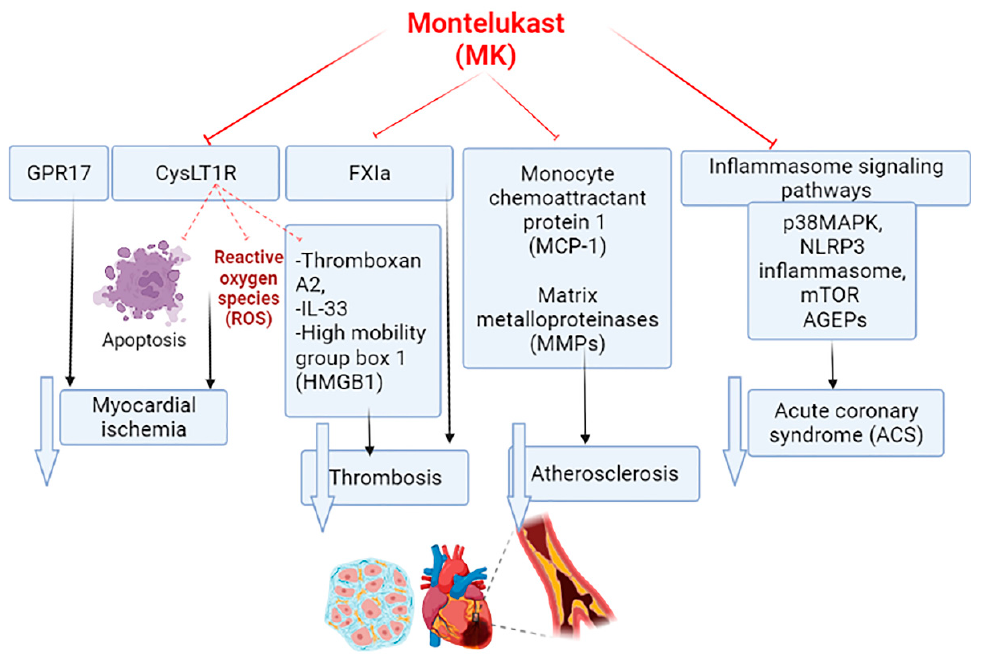
Figure 3. Mechanisms of montelukast in different cardiac and vascular diseases: Montelukast (MK) inhibits inflammasome signaling pathways, including p38 mitogen-activated protein kinase (p38MAPK), nod-like receptor pyrin 3 (NLRP3) inflammasome, mechanistic target of rapamycin (mTOR), and advanced glycation end-products (AGEPs). In addition, MK attenuates activation of cysteinleukotrine (CysLT) and activated factorXI with subsequent inhibition of inflammation and thrombosis-induced myocardial infarction and acute coronary syndrome (ACS).